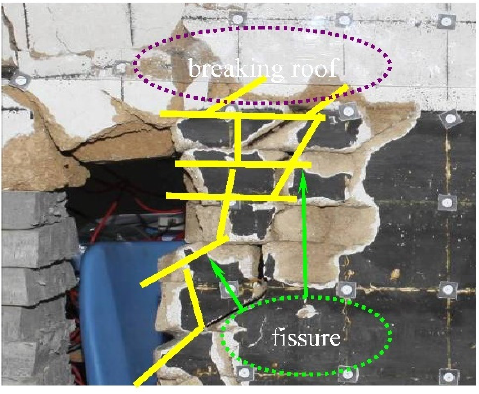
Figure 8. Development of joint and instability form the coal wall rib-spalling ( α = 30°).